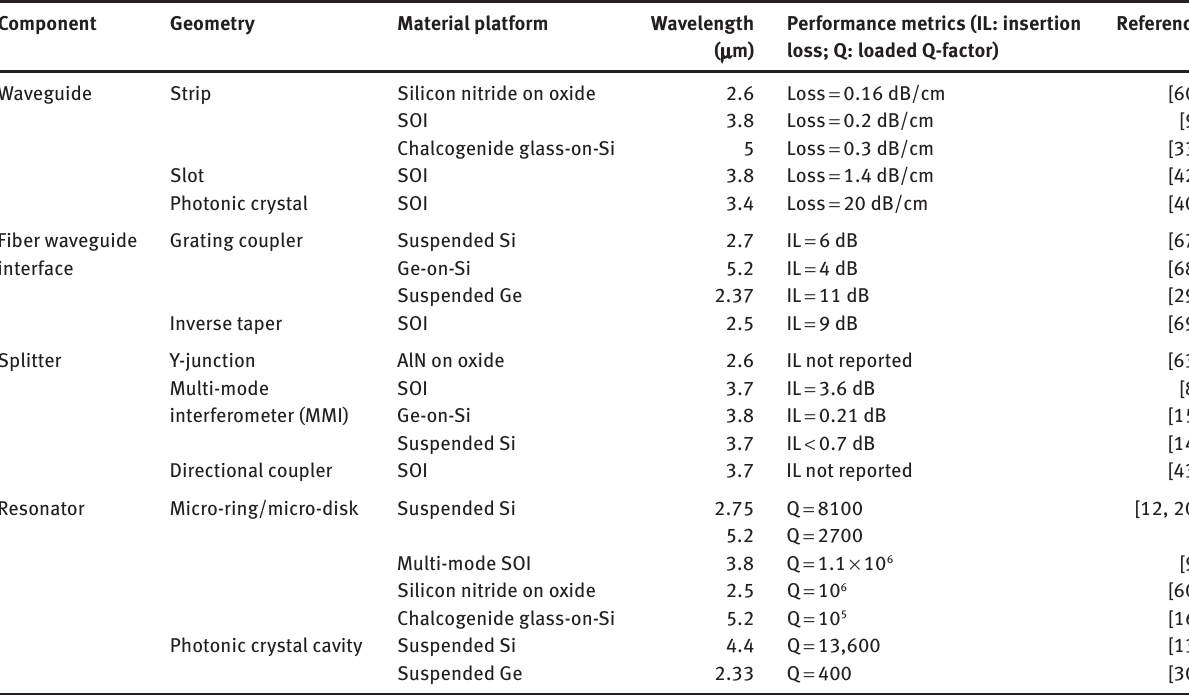
Table 2: Passive mid-IR components on Si and their state-of-the-art performance. Component Geometry